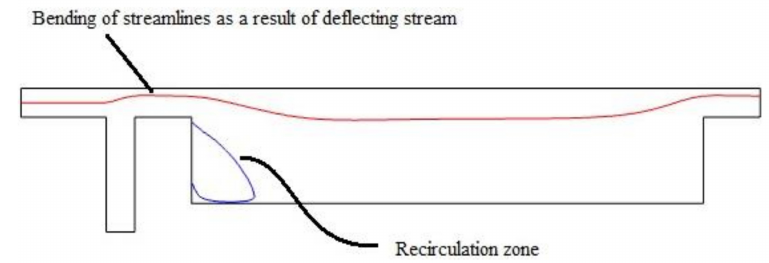
Figure 5. Consequences of adding ancillary channel: from the illustration, it is obvious that, by introducing this perpendicular flow, the streamlines are shifted upward. A circulation zone will also be formed at the bottom edge.